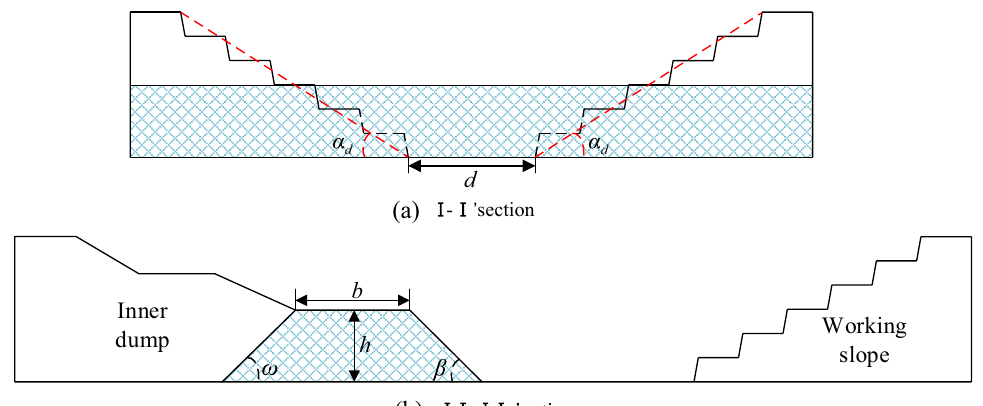
Fig. 1 Location of supporting coal pillar